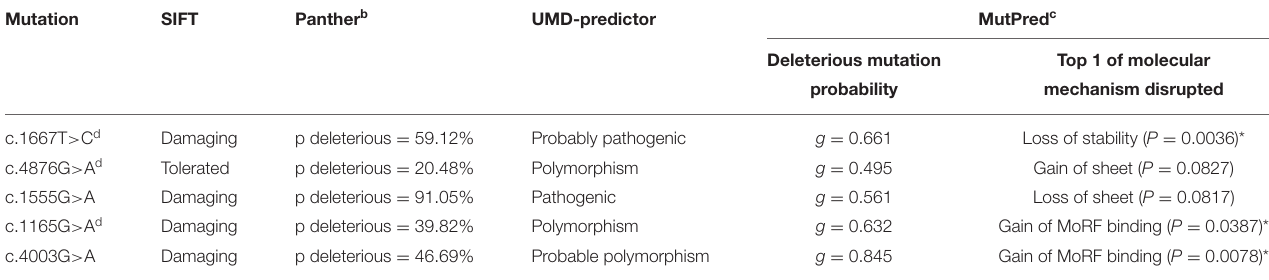
TABLE 2 | In silico prediction of mutation effect on protein function a .